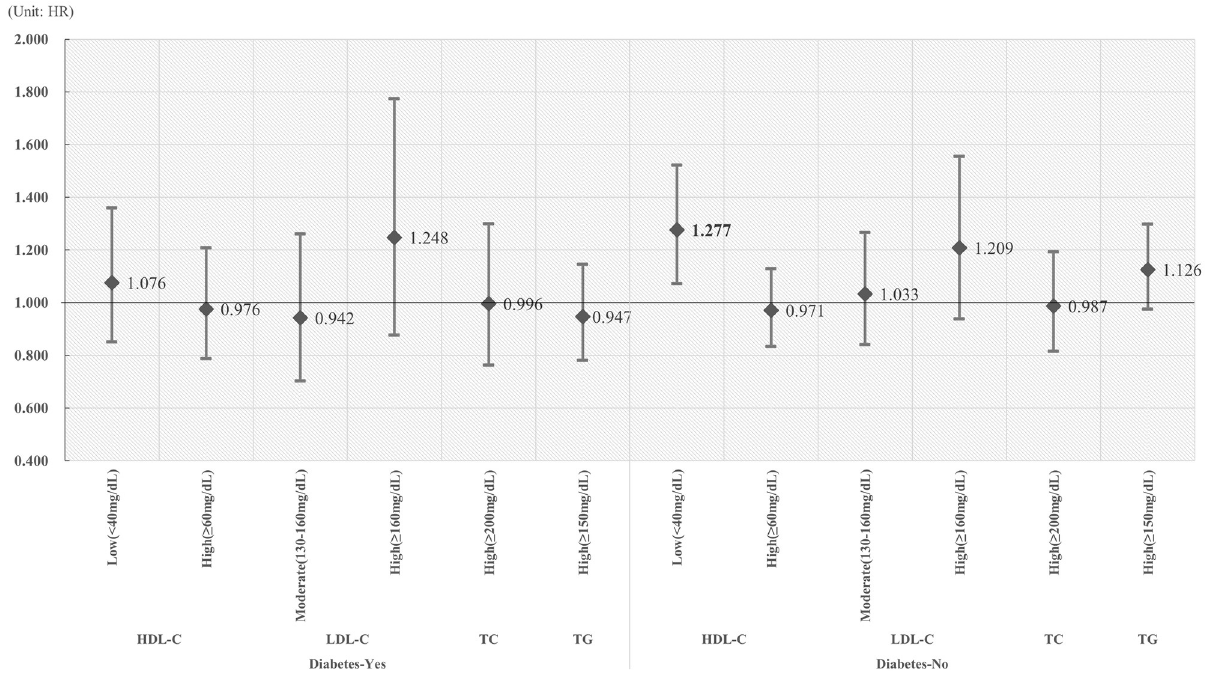
Fig 1. The association between serum cholesterol levels and CRC risk in patients with or without diabetes. Bold is statistically significant.